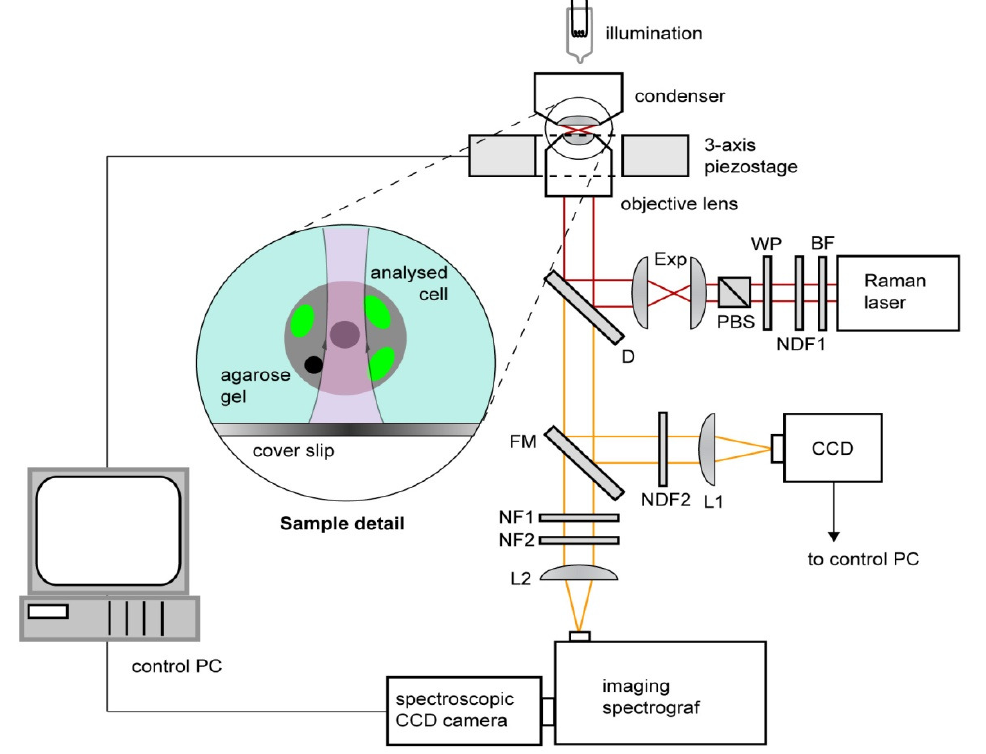
Figure 2. Schematic diagram of the experimental setup for Raman